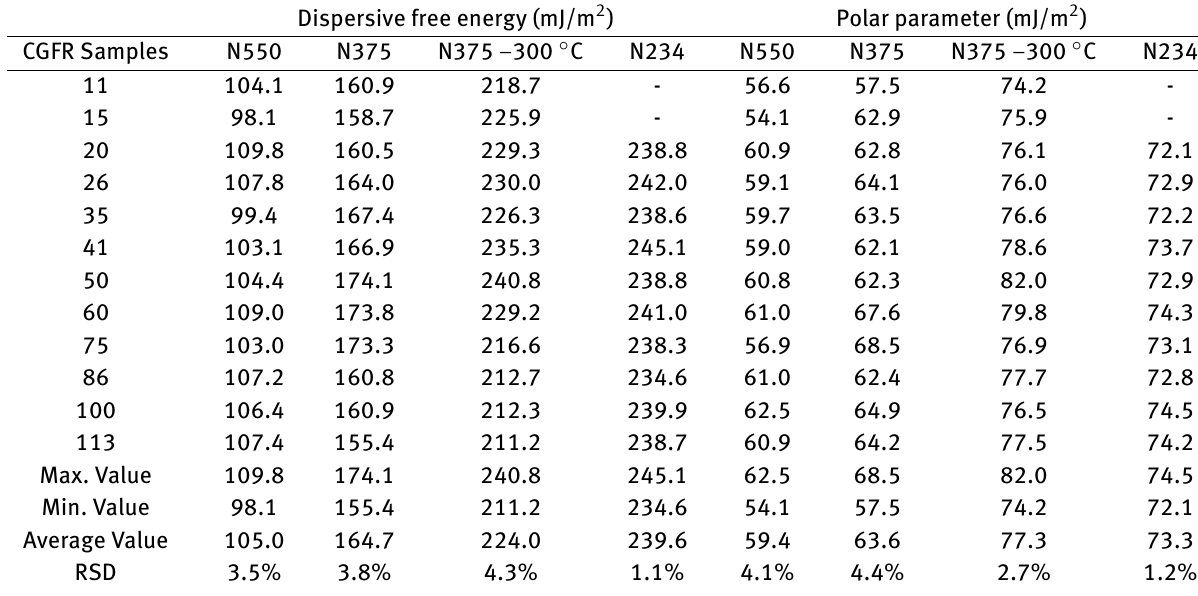
Table 4: CB surface free energy measured at different carrier gas flow rates